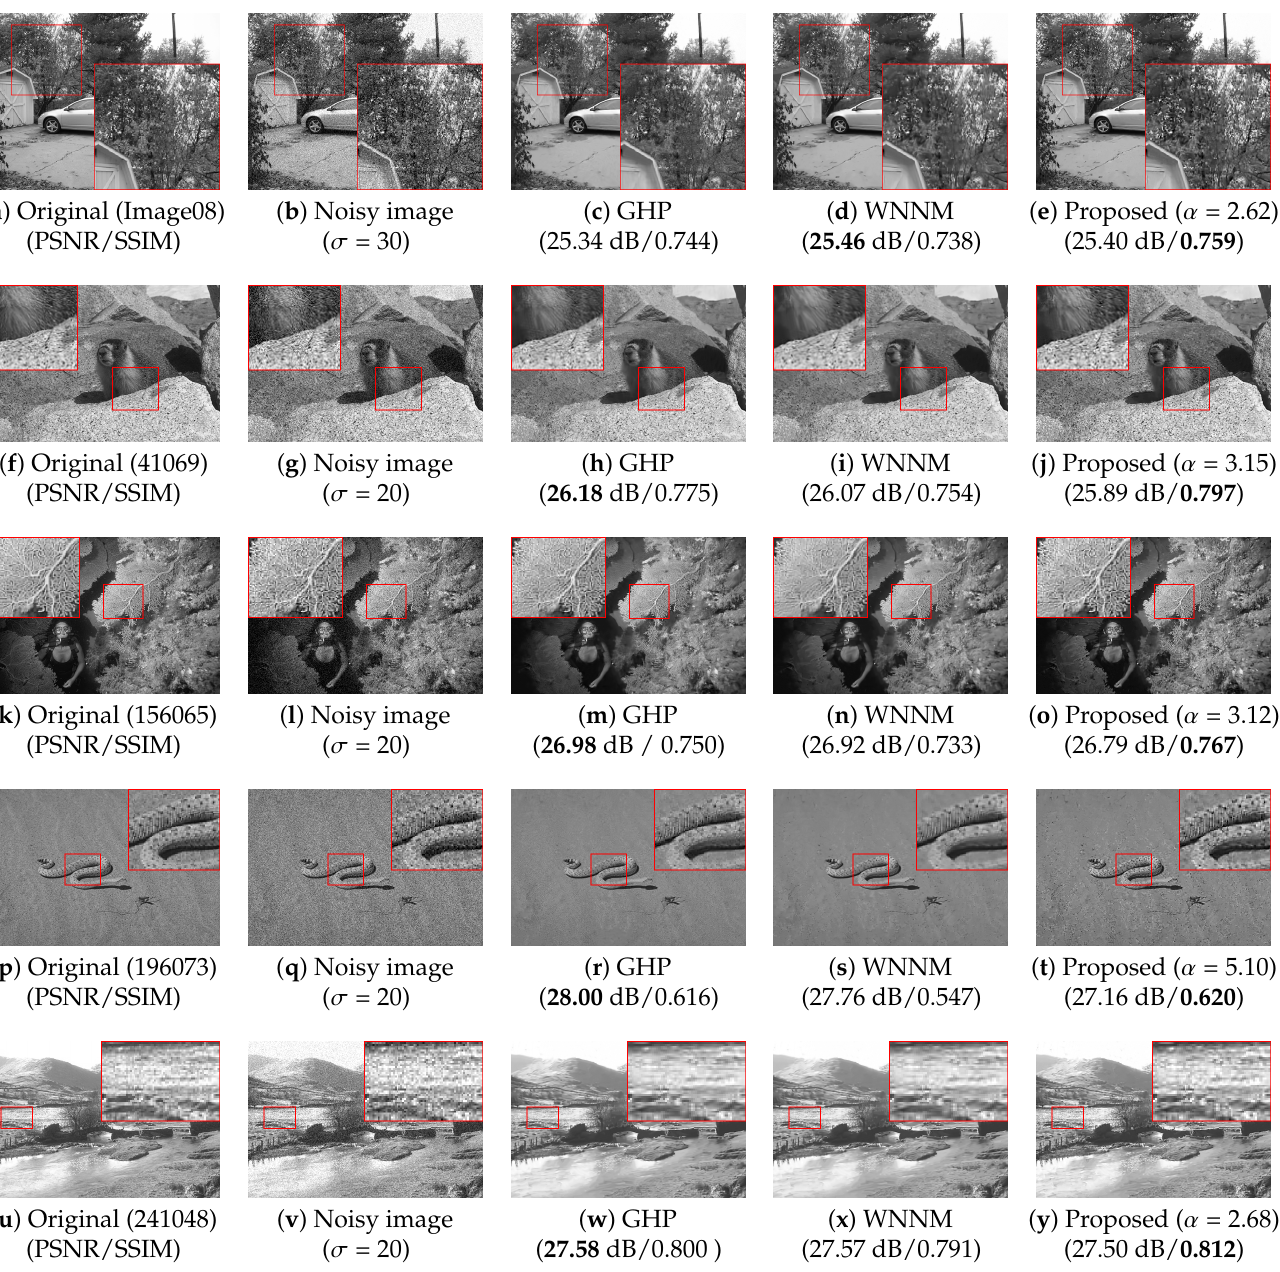
Figure 4. Performance comparison of GHP, WNNM, and the proposed method. A histogram of the 𝛼 SSIM values obtained on BSD100 is shown in Figure 6. We note that this histogram shows the frequency under three noise levels ( 𝜎 = 10, 20, 30). This figure indicates that there is no single optimal value of 𝛼 SSIM that is common to all images. Nevertheless, the figure also shows that choosing 𝛼 = 2 will almost always increase the expected value of the SSIM. Moreover, as with 𝛼 SSIM , we searched for the value of 𝛼 that would maximize the PSNR of the output image, and denoted it by 𝛼 PSNR . We obtained 𝛼 PSNR for each image via a line search in the range from 0 to 8 in increments of 0.01. Figure 7 shows a histogram of the values of 𝛼 PSNR . We confirmed that 𝛼 = 1 produces the denoised images with the best PSNR in most